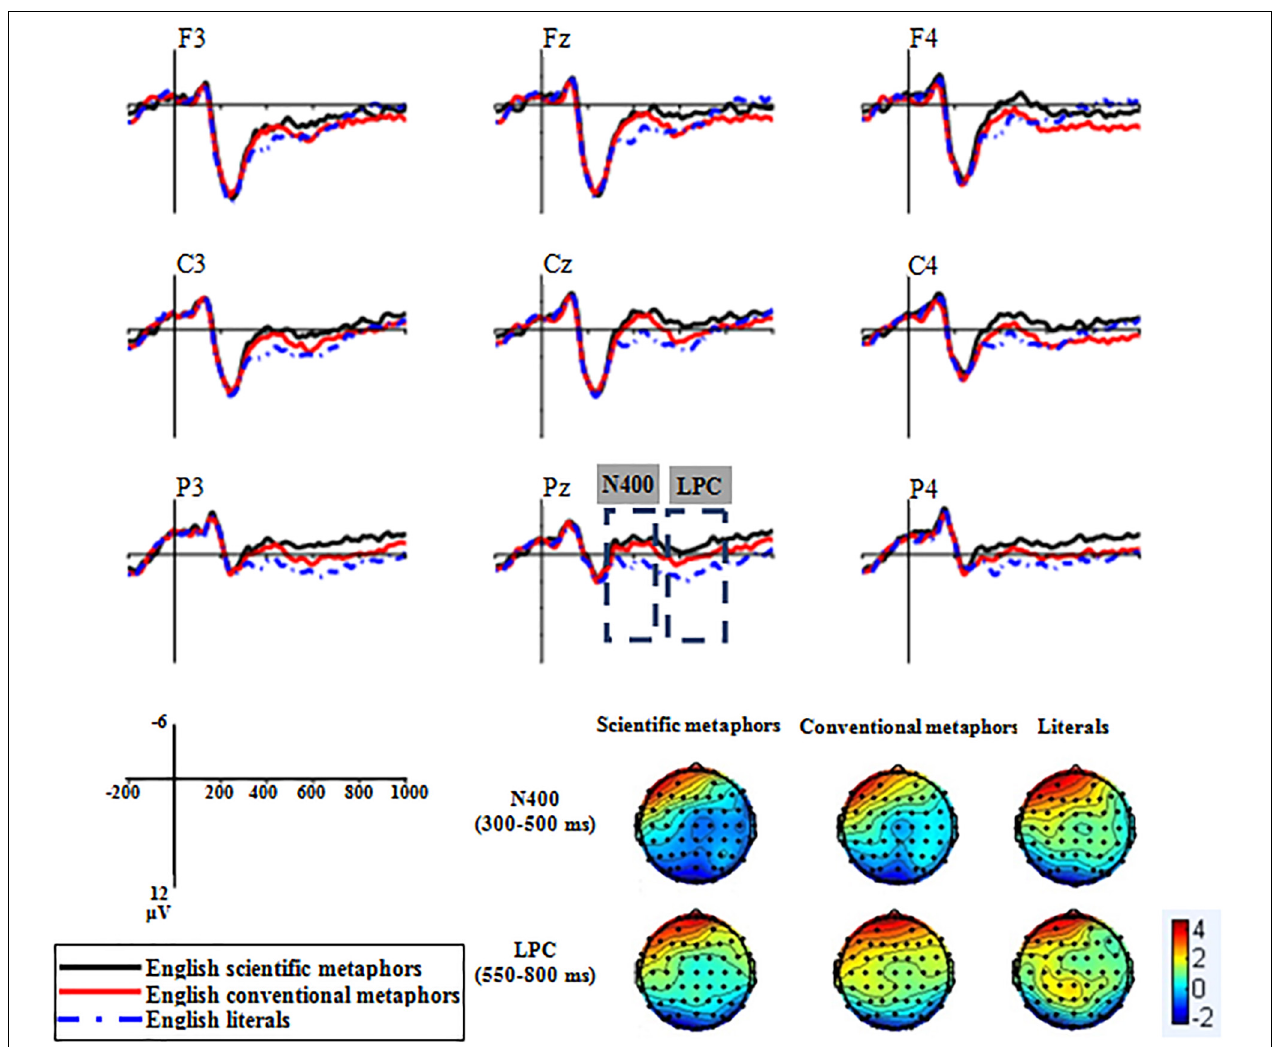
FIGURE 5 | Grand average ERP waveforms of Experiment 2 recorded at the nine chosen